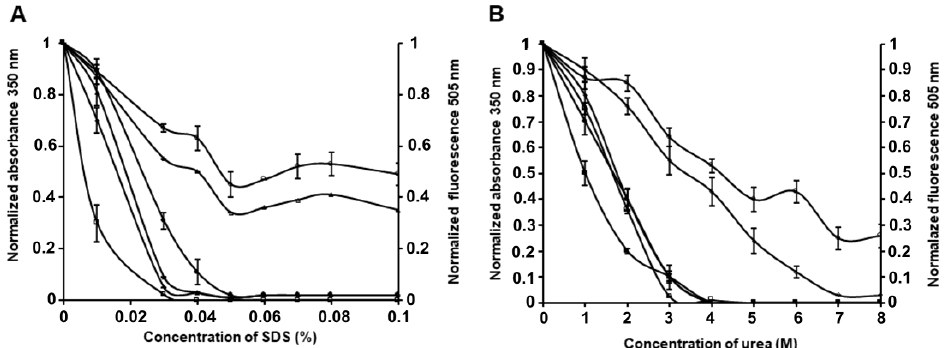
Figure 6. Solubility of PldA-GFP IBs in SDS ( А ) and urea ( B ). Dependence of turbidity signal (solid symbols) and GFP fluorescence (empty symbols) of IBs incubated in denaturant solutions for 5 min (circle), 1 h (triangle), 2 h (rhombus), and 24 h (square) on the denaturant concentration. The experiments were performed in three biological replicates. Results show the mean ± standard deviation (SD).